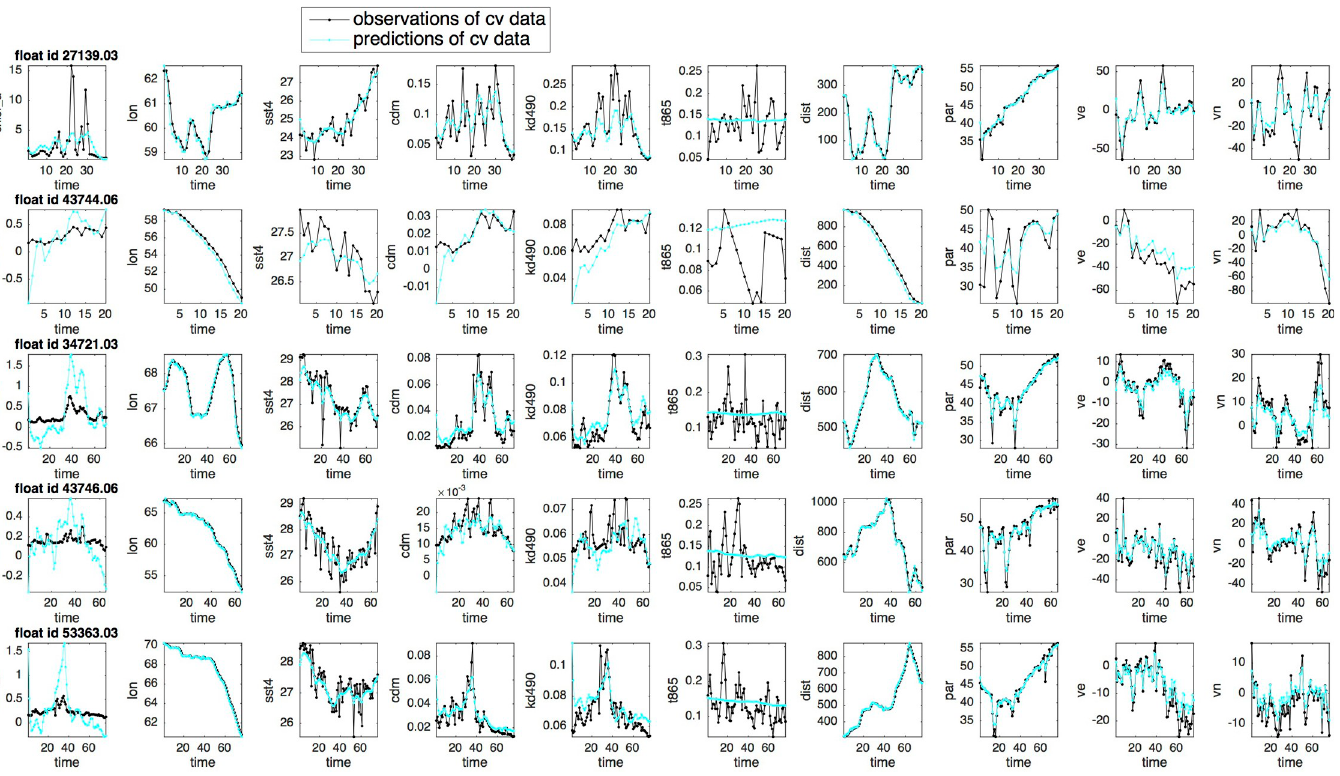
Fig 10. Predictions of the drifter profiles for the floats in the cross-validation dataset, using the expected conditional mean of the latent variables at the last iteration of the Expectation-Maximization algorithm.